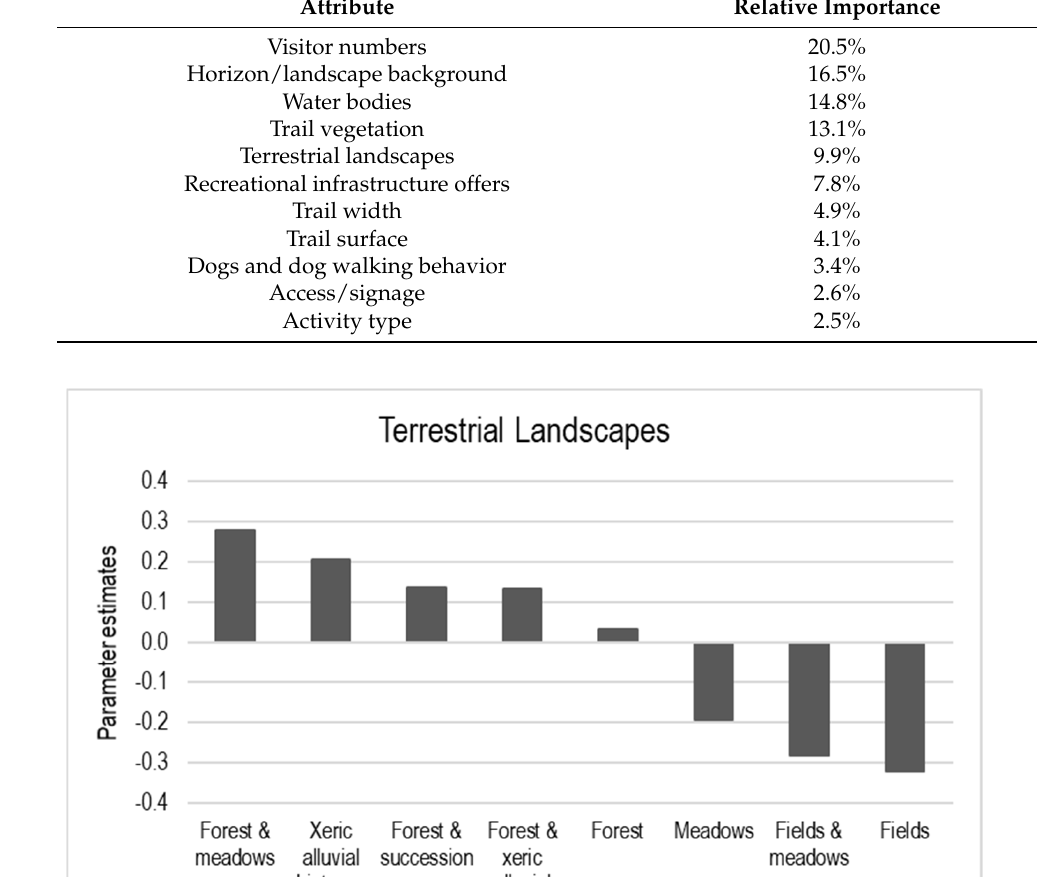
Figure 5. Preferences for terrestrial landscapes ( n = 520).